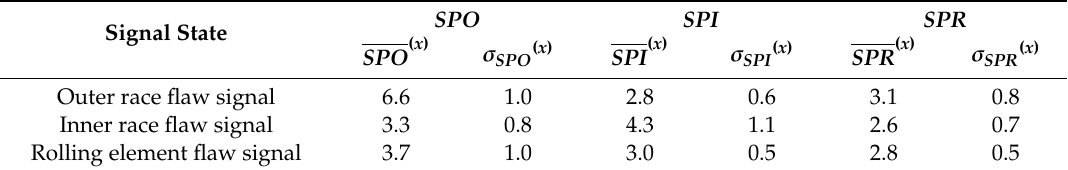
Table 4. 𝑆𝑃𝑥̅̅̅̅̅ and 𝜎 𝑆𝑃𝑥 calculated in each state of CH3 for learning. Table 4. SPx and σ SPx calculated in each state of CH3 for learning.